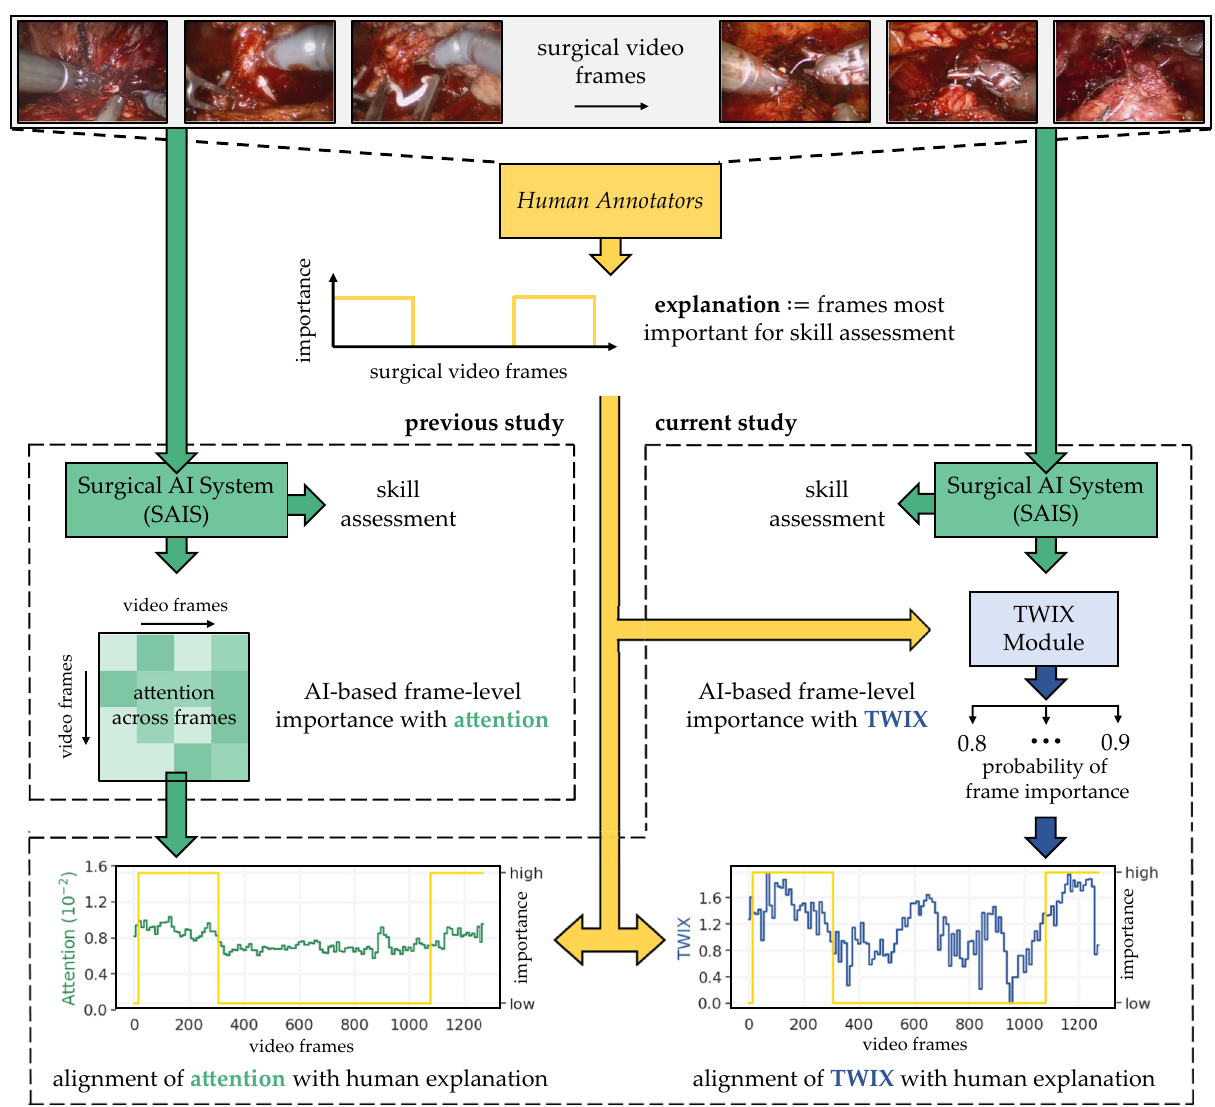
Fig. 2 Quantifying the alignment of AI-based explanations with human explanations. A surgical arti fi cial intelligence system (SAIS) can assess the skill of a surgeon based on a surgical video and generate an explanation for such an assessment by highlighting the relative importance of video frames (e.g., via an attention mechanism). Human experts annotate video frames most important for the skill assessment. TWIX is a module which uses human explanations as supervision to explicitly teach an AI system to predict the importance of video frames. We show the alignment of attention and TWIX with human